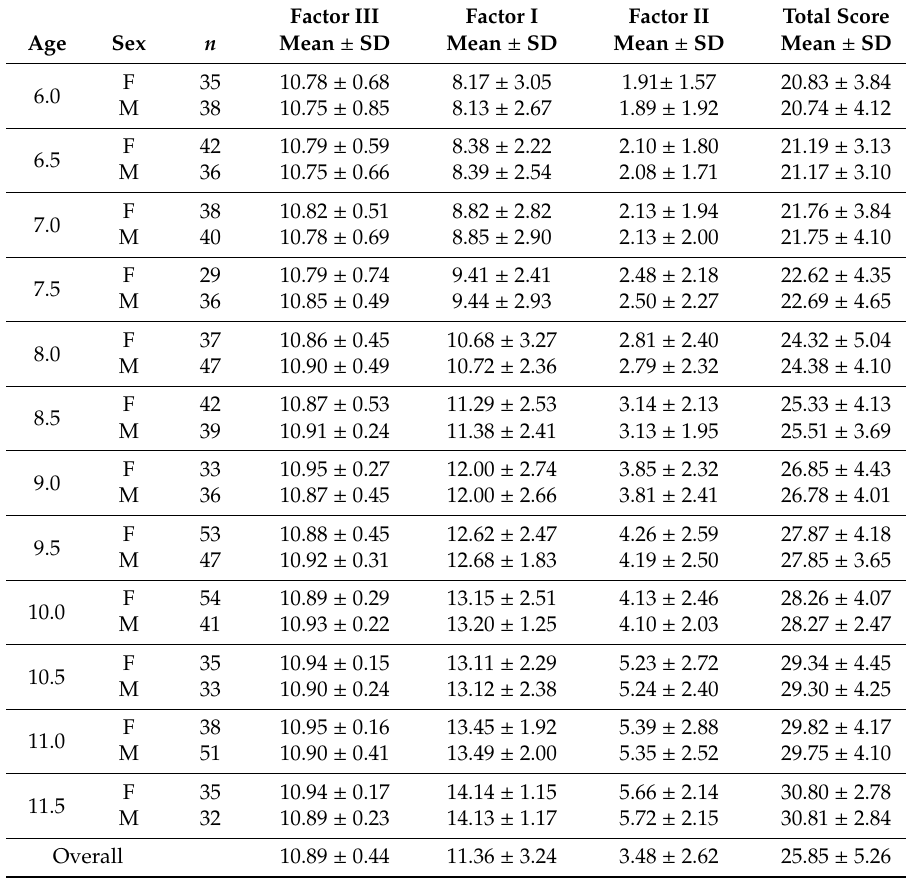
Table 4. Mean and standard deviation of RCPM scores in the three factors, according to a breakdown of the sample by age and